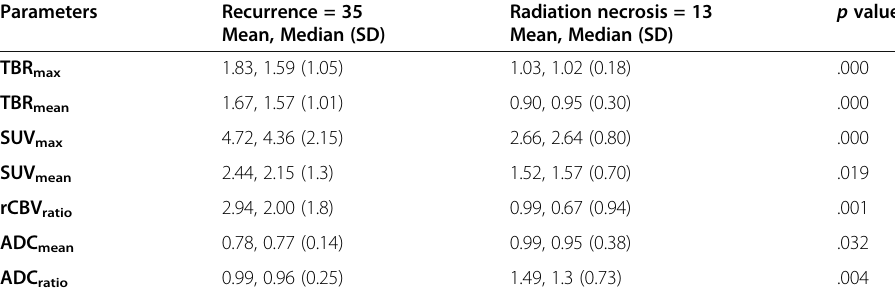
Table 1 Median, mean, standard deviation (SD) for PET, perfusion, and diffusion parameters in either group with p values obtained using the Mann-Whitney test Parameters Recurrence = 35 Mean, Median